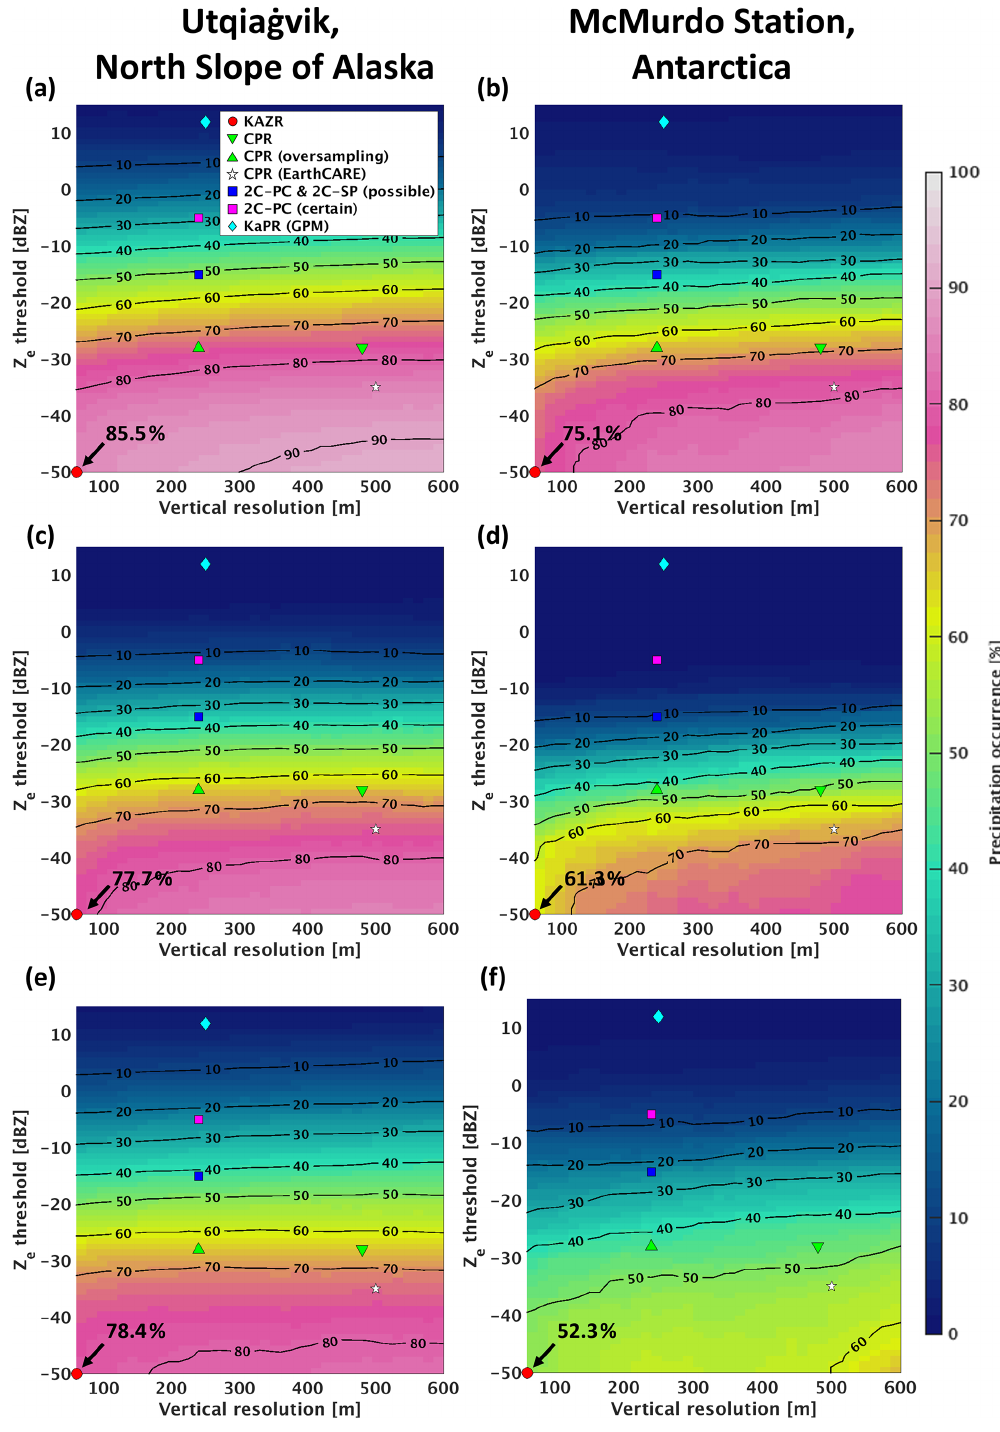
Figure 1. Precipitation occurrence over the Arctic site (a, c, e) and Antarctic site (b, d, f) as a function of radar range resolution and equivalent radar reflectivity ( Z e ) threshold: (a, b) for all supercooled cloud layers at liquid cloud base, (c, d) for the uppermost supercooled layers with no overlying hydrometeor detections, and (e, f) for surface precipitation (defined here as ∼ 300m above ground level) from all layer-containing columns. Symbols indicate the range resolutions and detectability thresholds for the KAZR at ∼ 1km above ground level, the CloudSat CPR, EarthCARE CPR, the GPM KaPR, and the CloudSat 2C-PC and 2C-SP precipitation detection algorithms (for possible liquid and ice precipitation or certain ice